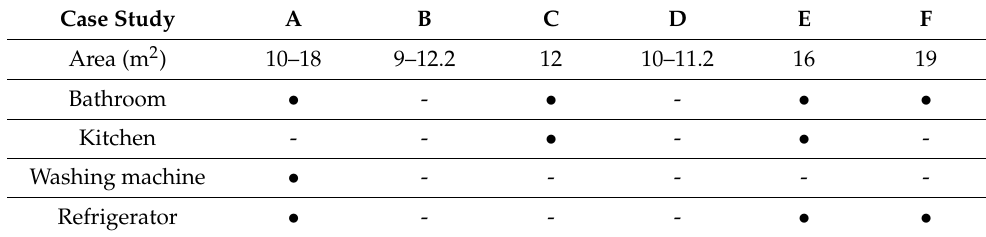
Table 10. Components of personal space in each case study (yes • , no -).